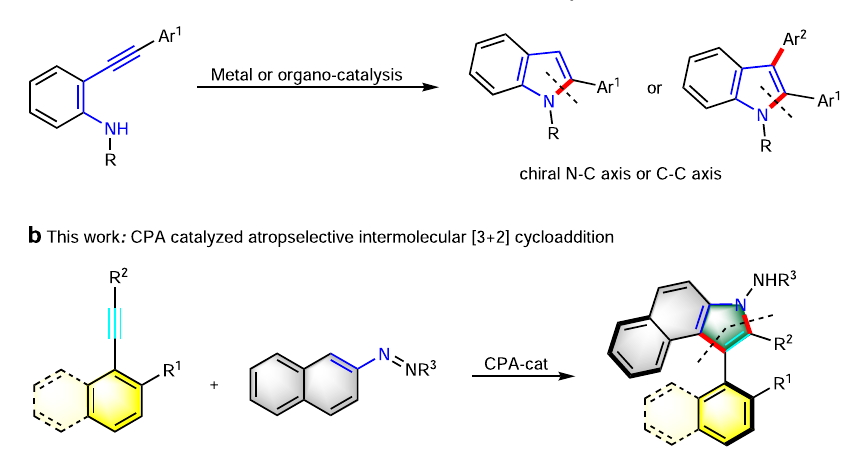
Fig. 1 Asymmetric construction of indole-based biaryls via cycloaddition strategies. a Construction of indole derivatives via intramolecular cyclization. b CPA-catalyzed atroposelective intermolecular [3 + 2]